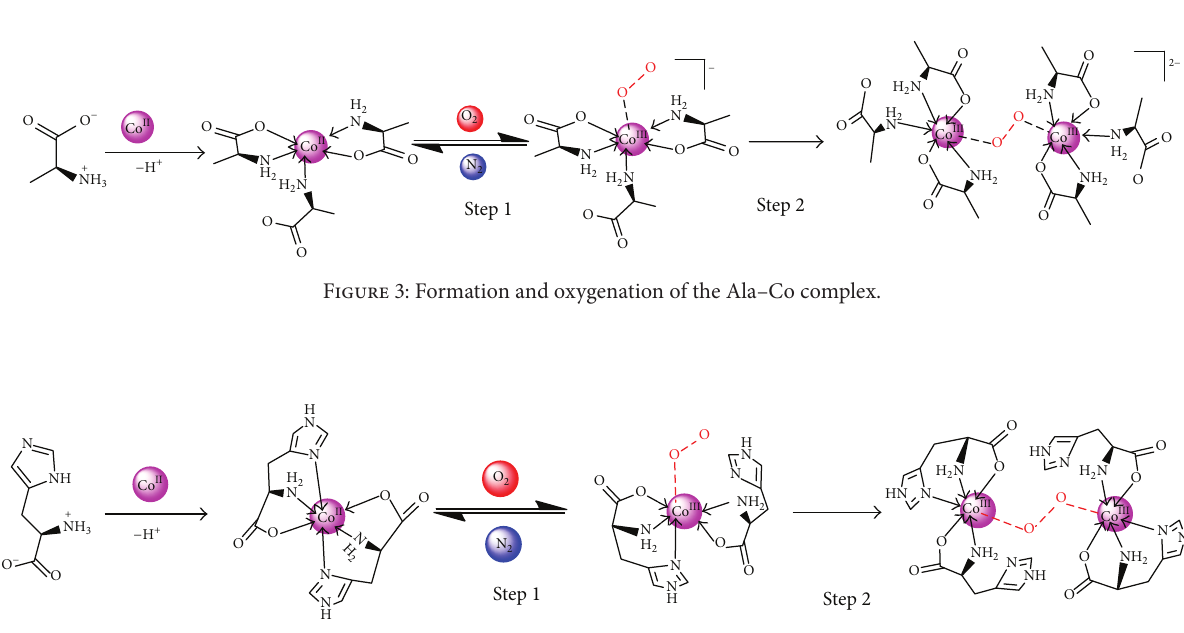
Figure 4: Formation and oxygenation of the His–Co